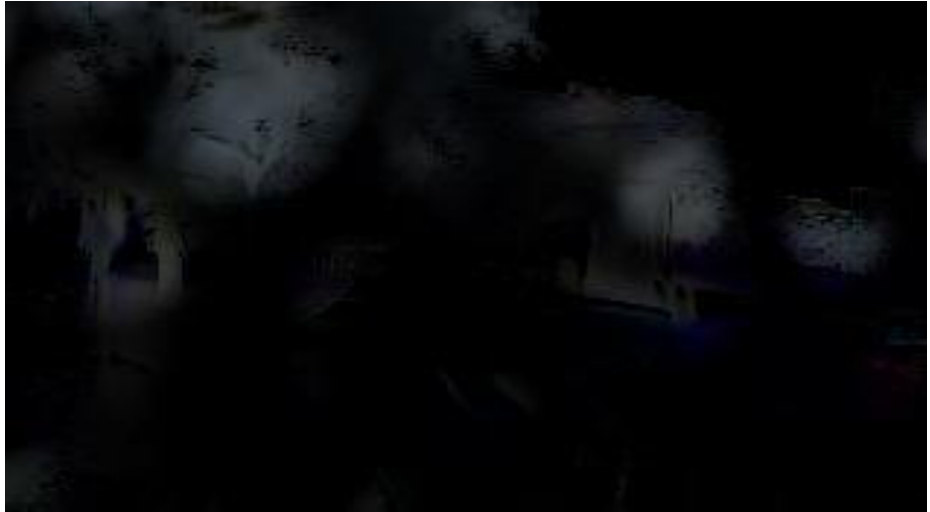
Figure 13. Attention map of the rainy day scene sample image.